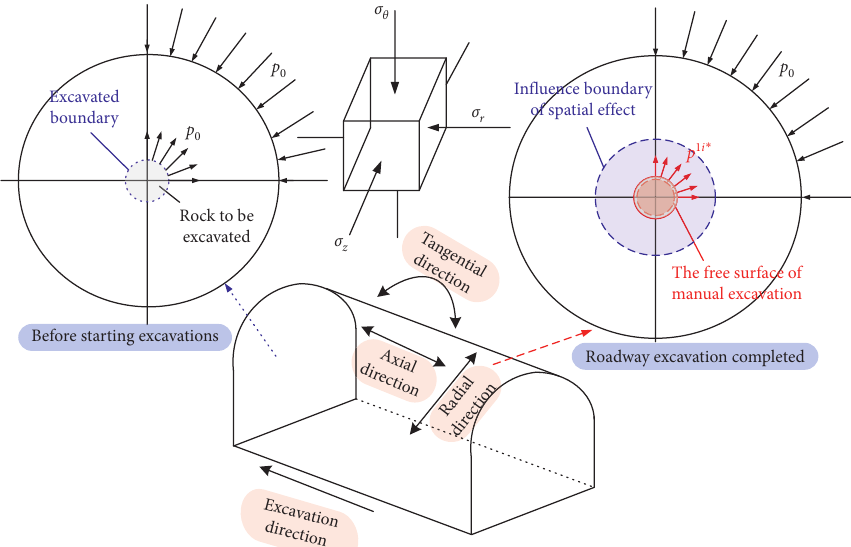
Figure 4: Mechanical model of roadway